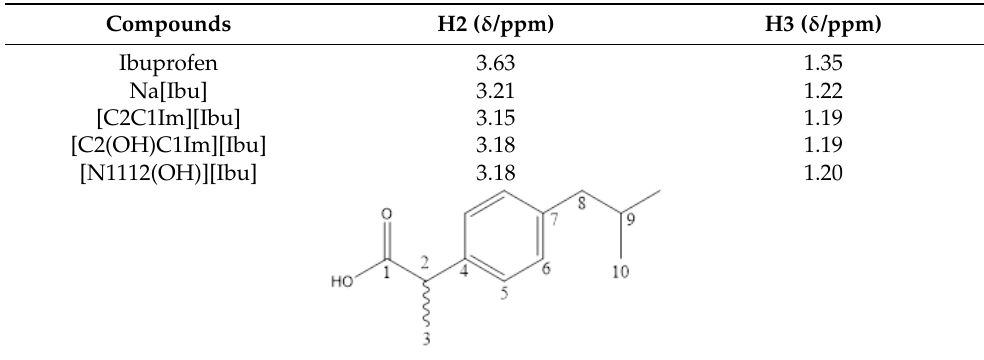
Table 2. Chemical shifts for the hydrogens in positions 2 and 3 (as depicted in the chemical structure of ibuprofen on the bottom) for ibuprofen, sodium ibuprofen and API-ILs in DMSO.